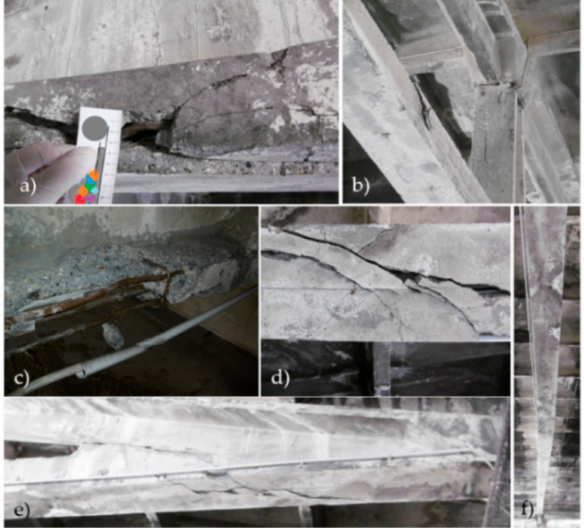
Figure 5. Examples of cable post-tensioned concrete girder damage in the Hall A inventoried from: ( a ) a basket lift; ( b – f ) using UAV